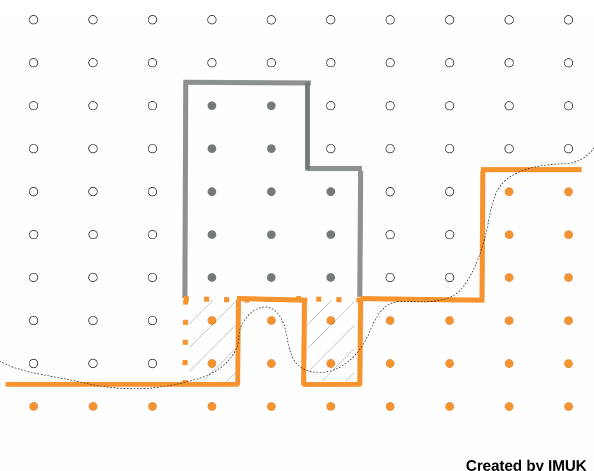
Figure 12. Schematic illustration on how buildings are mapped onto the underlying terrain. The thin dashed black line indicates the orig- inal relative terrain height z (cid:48) t . Solid orange lines indicate the origi- nal discrete terrain surface, while dashed orange lines indicate the resulting discrete terrain surface after the terrain is flattened below buildings, as indicated by the hashed areas. Grey solid lines indicate building surfaces. Orange and grey coloured points indicate terrain and building grid points, respectively, while non-filled points indi- cate atmospheric grid